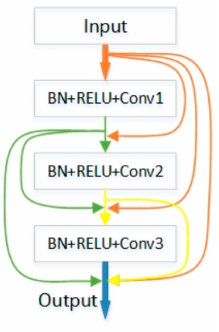
Figure 5. The basic schematic of a 4-layers dense